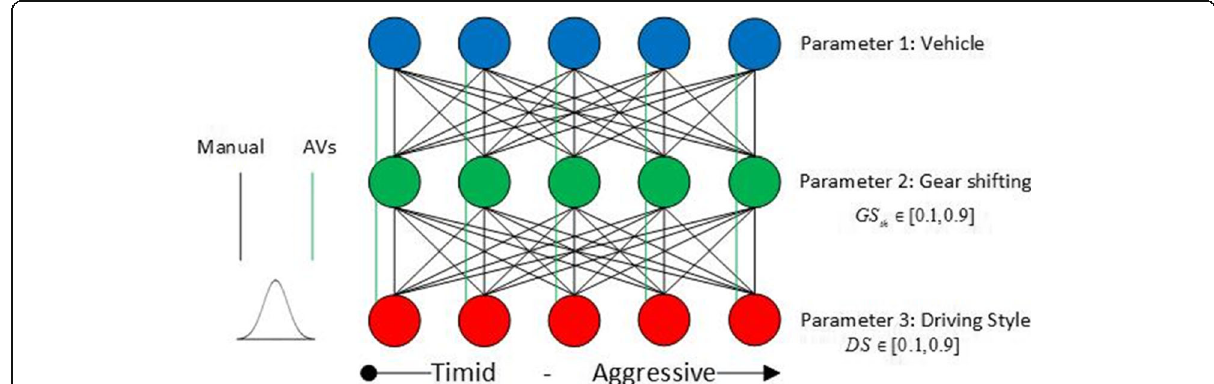
Fig. 3 Creation of 125 individual driving profiles DP i by choosing from a pool of 5 different cars, 5 gear shifting strategies and 5 driving styles. AVs are shown with green line and correspond to 5 individual profiles, one per each vehicle. The selection of the profiles during each simulation is performed based on a normal distribution around the average profile, i.e. the second value of each